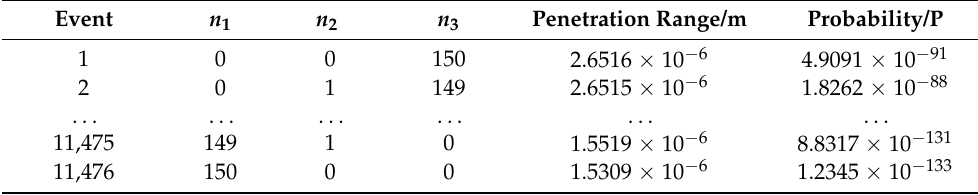
Table 2. The different initial velocities, the penetration distances, and the probabilities of silver ions in different